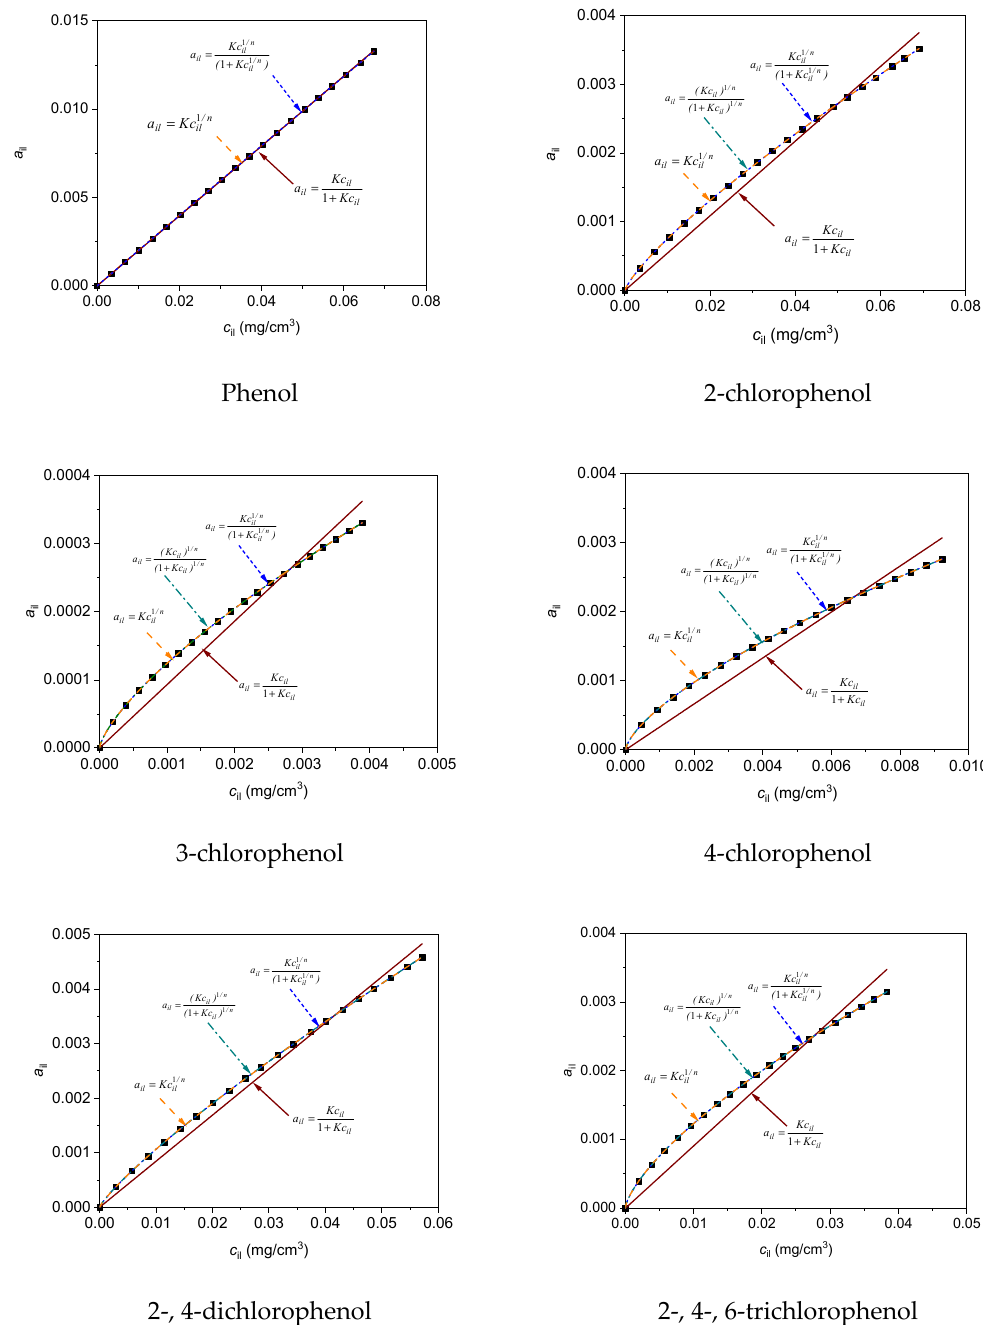
Figure 6. Adsorption isotherms for adsorbates at 298 K on adsorbent HDTMA/HAL. Solid lines represent curves obtained from the application of Langmuir Equations (16)–(19) to the adsorption data as adjusted by the least-squares method.